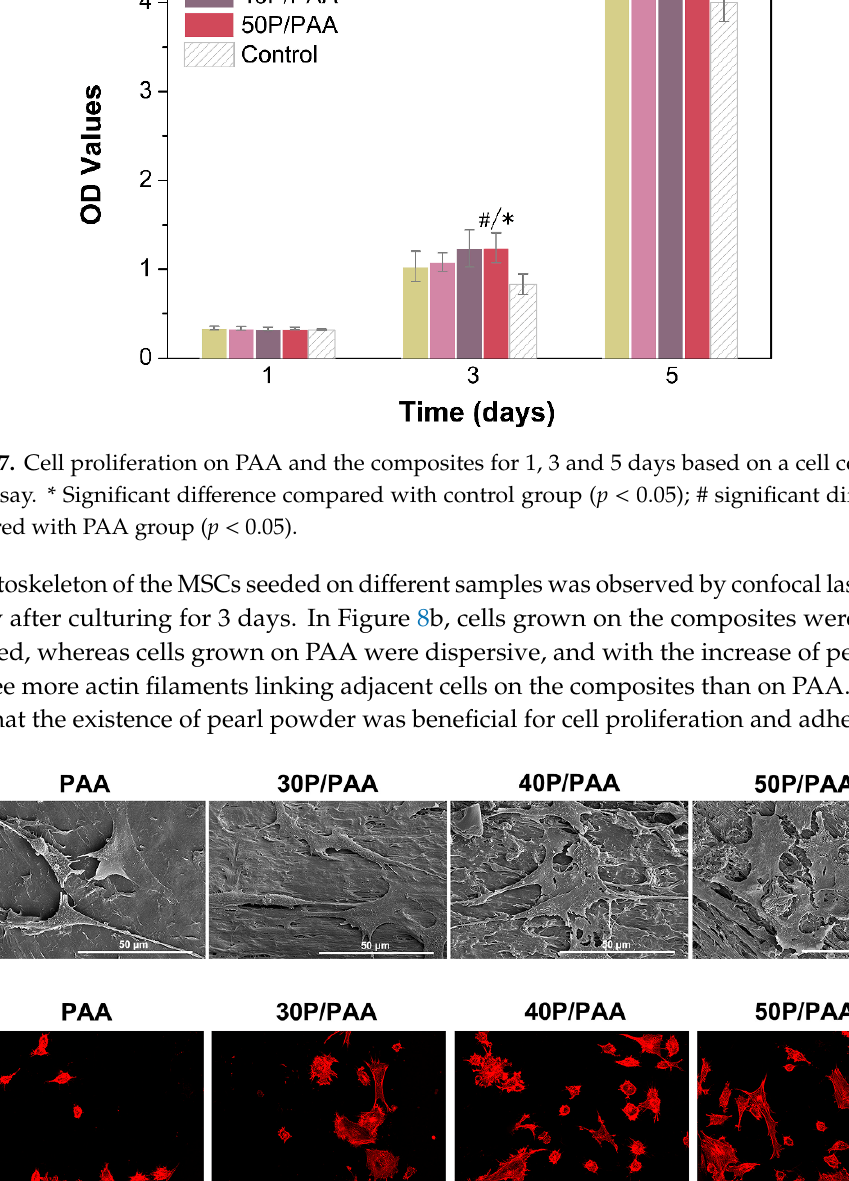
11 of 19 Figure 6. Variation of the Ca ion (left) and P ion (right) concentrations of SBF after the samples soaked for 0, 1, and 7 days. 3.6. Cell Proliferation To evaluate cell proliferation on PAA and the P/PAA composites at 1, 3, and 5 days, the CCK8 assay was carried out. The obtained results were displayed in a bar graph of OD-culture time (Figure 7). In Figure 7, we could see that as the incubation time increased, MSCs proliferation increased